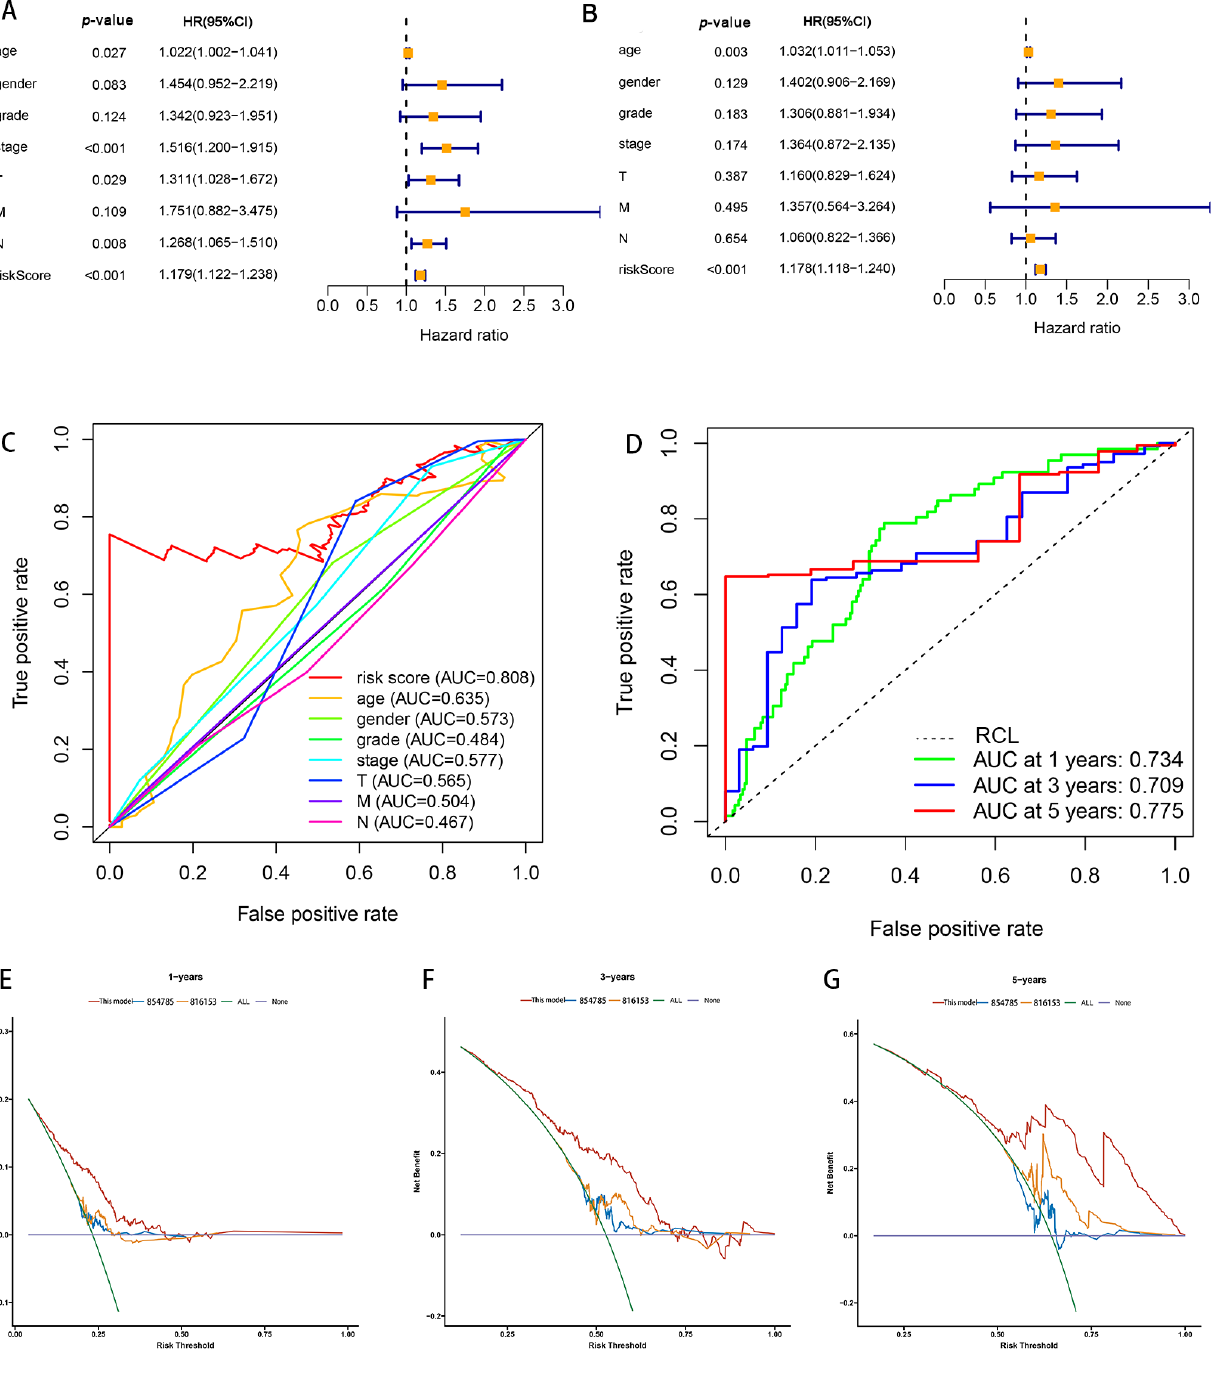
Figure 4. Correlation of risk models regarding the six PRlncRNAs with a prognosis in GC. ( A ) The univariate Cox regression analysis. ( B ) The multivariate Cox regression analysis. ( C ) The ROC curves, which showed the AUC for the risk scores and clinicopathological variables. The clinicopathological variables were as follows: age, sex, grade, TNM stage, T, and tumor. Abbreviations — M: metastasis and N: lymph node. ( D ) The ROC curves and AUCs for the one-, three-, and five-year survival rates, as per the risk model. ( E – G ) Decision curve analysis (DCA) curves for overall survival at 1, 3, and 5 years to evaluate the efficacy of different clinical models, and the red line represents this model; the orange line represents the model from [31] ; the blue line represents the model from [32] . RCL: random guessing line, the baseline of a ROC curve.